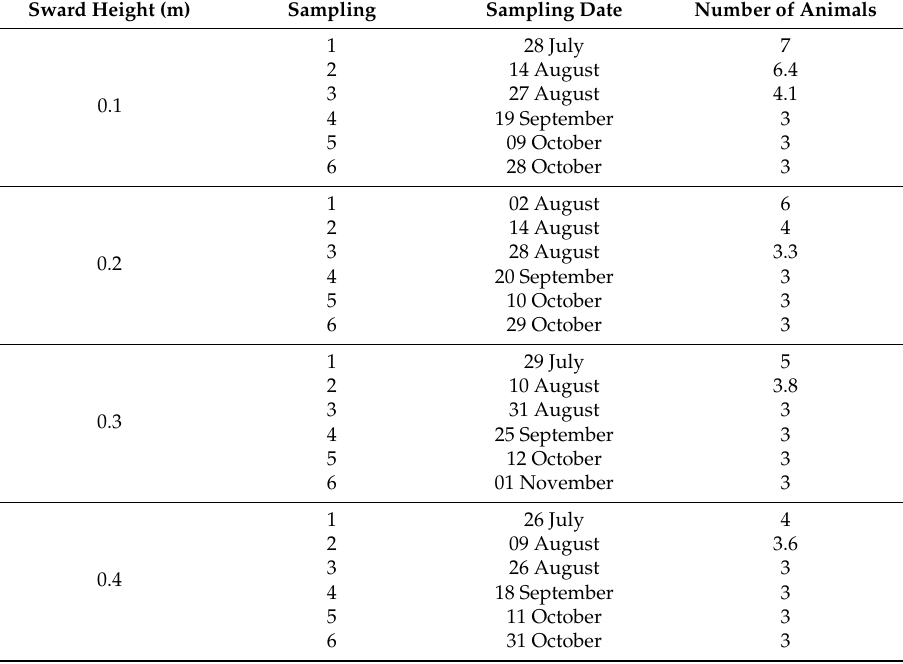
Table 1. The average number of animals (beef steers) per paddock at each dung sampling date in 2010 for the different grazing intensities (sward heights of 0.1, 0.2, 0.3 and 0.4 m) on mixed black oat ( Avena strigosa Schreb.) and Italian ryegrass ( Lolium multiflorum Lam.) pastures in the stocking period of an integrated soybean-beef cattle system in southern Brazil.